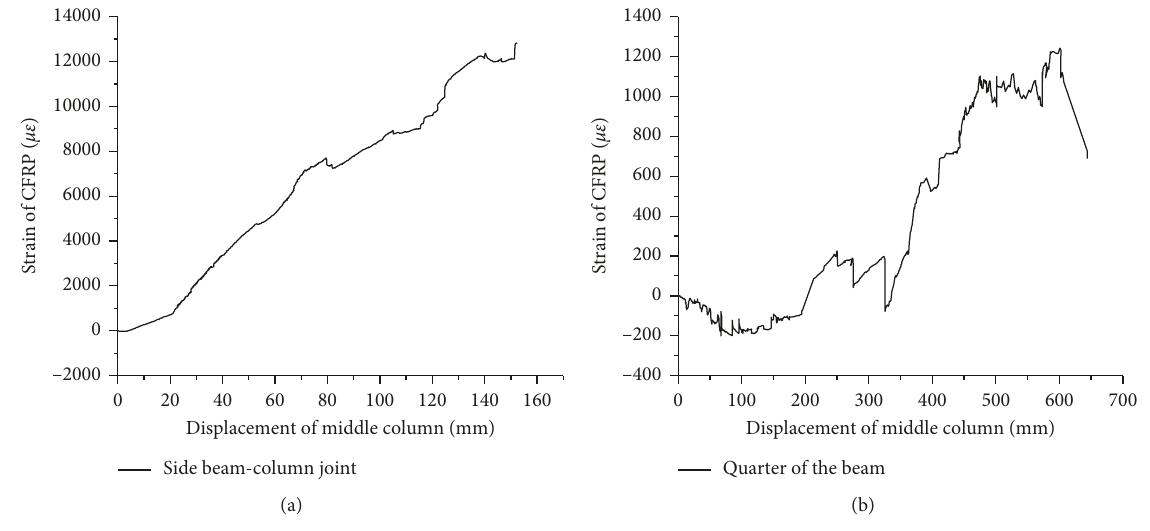
Figure 14: Strain of CFRP. (a) Strain of CFRP near the side column. (b) Strain of CFRP at 1/4 beam